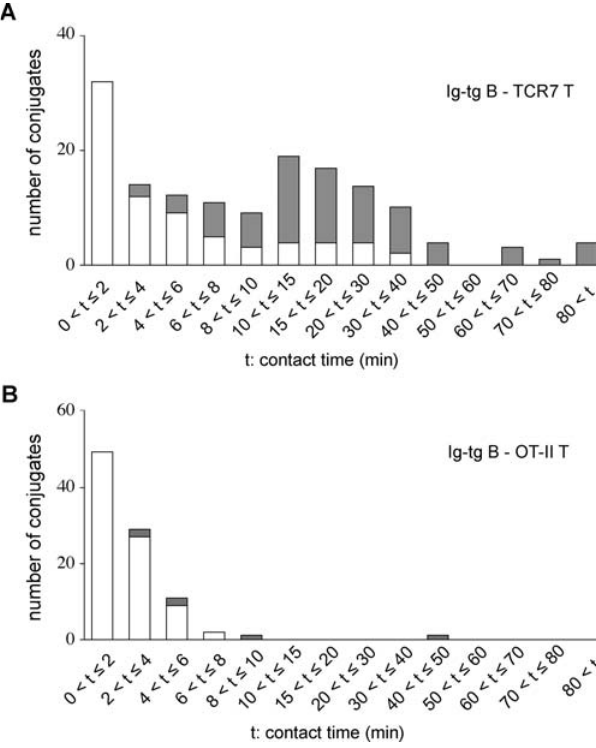
Figure 7. Contact Times of Antigen-Engaged B cell–Helper T Cell Conjugates (A) The histogram shows contact time distribution for Ig-tg B cells and TCR7 CD4 þ T cells 30 to 50 h after immunization with antigen with adjuvant. Open bars show conjugates that were tracked for the duration of contact and shaded bars show conjugates that could not be tracked for the entire period of contact because the cells entered the field as a conjugate, left the field as a conjugate, or both. (B) Contact time distribution for Ig-tg B cells and OT-II CD4 þ T cells 1 to 2 d after antigen priming. Open and shaded bars as in